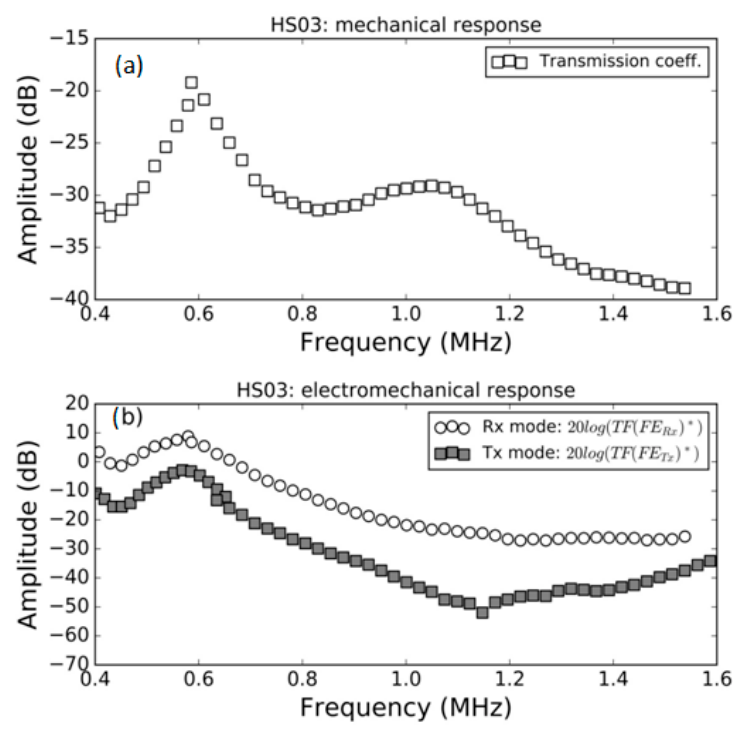
Figure 5. Measured response of the HS03 FE sample in air. ( a ) Modulus of the transmission coefficient vs. frequency ( b ) electromechanical response vs. frequency both in Tx and Rx mode, (see Equations (16) and (22)).